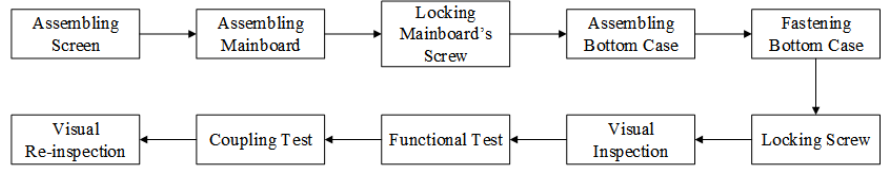
Figure 1. Assembly Process of Mobile